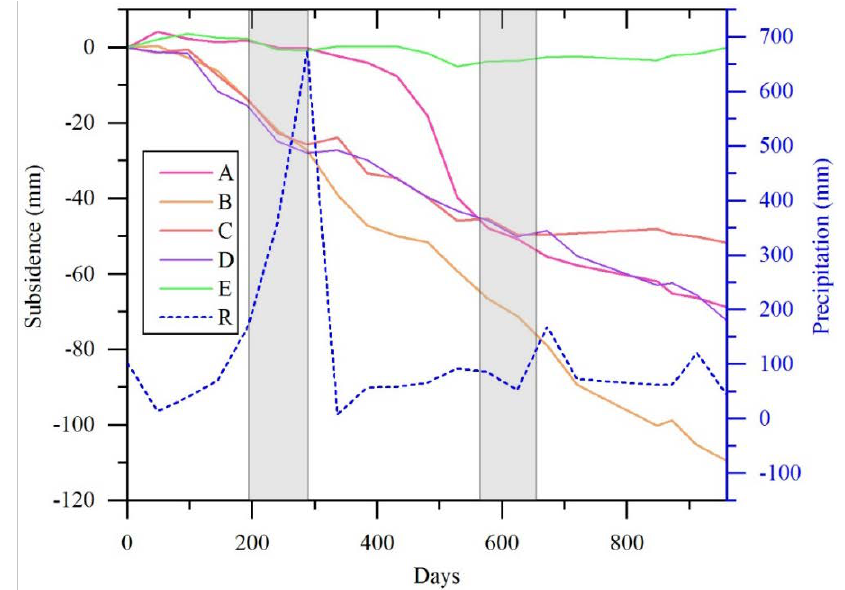
Figure 6. Time-series subsidence at the five typical points A–E. The gray rectangle denotes the early summer (May, June, and July).